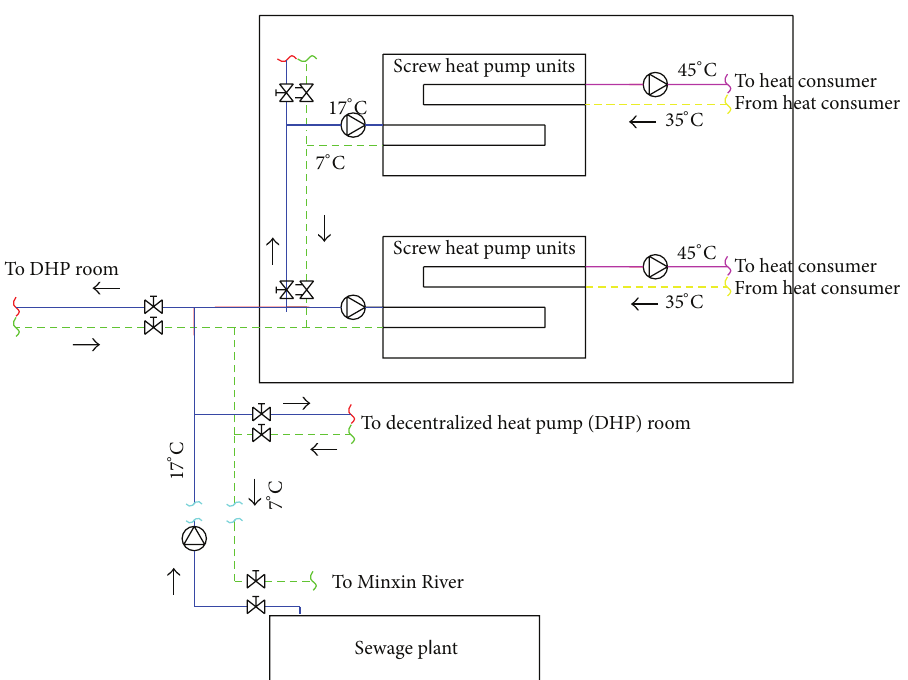
Figure 2: Schematic diagram of phase I project of heat pump